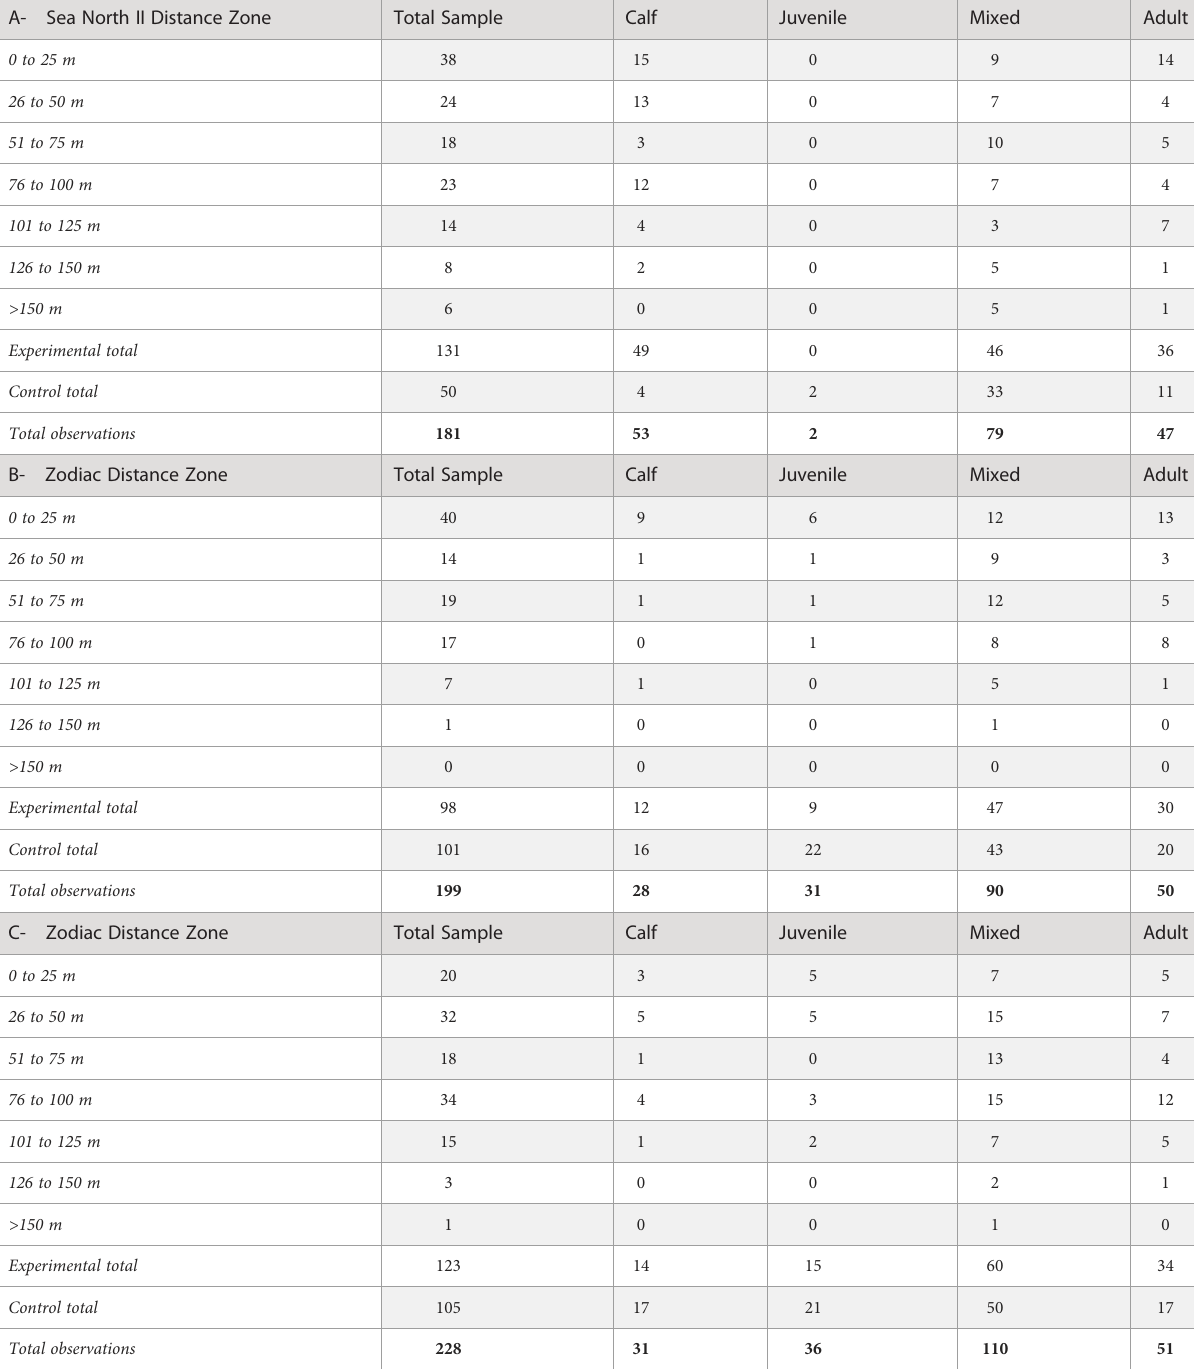
TABLE 3 Number of distance/behaviour observations of beluga whales in the Churchill estuary, Hudson Bay: A- from the Sea North II passenger vessel in 2019; B - from Zodiacs in 2020; C - from Zodiacs in 2021, and in all years from the control location. A- Sea North II Distance